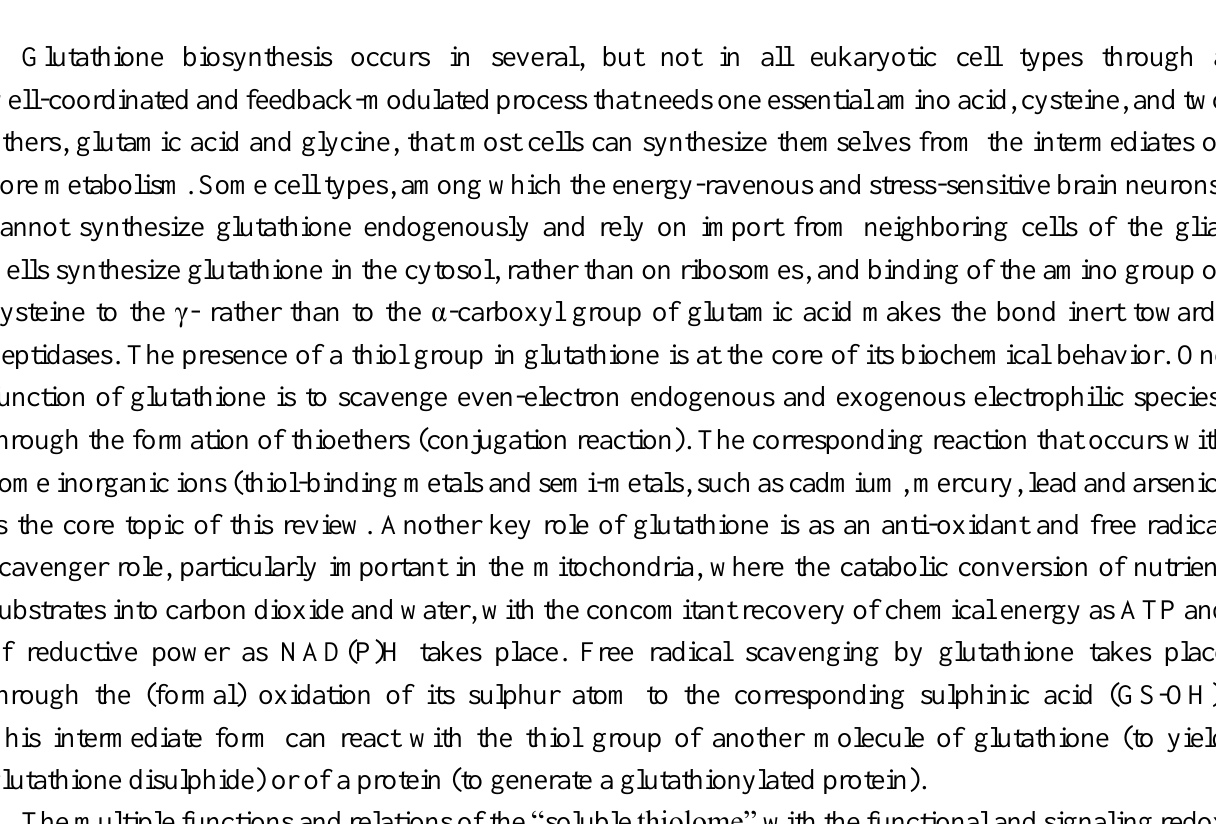
Scheme 1. Simplified metabolic grid of the soluble